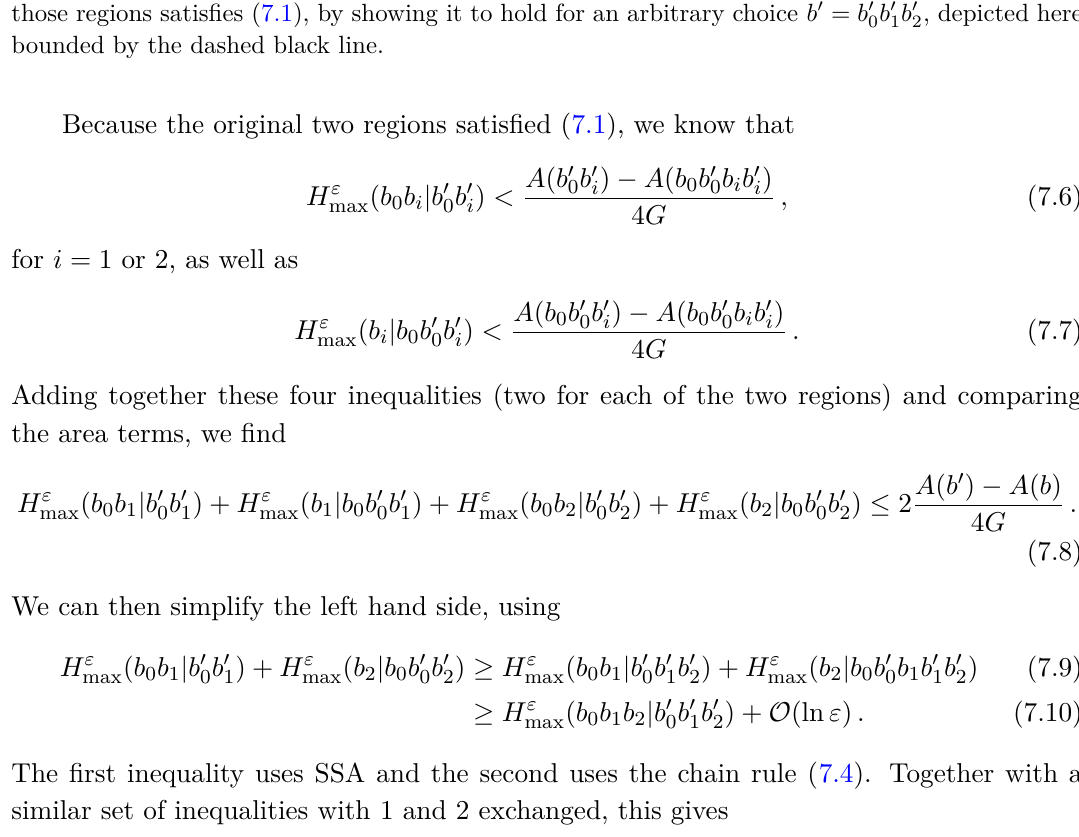
, depicted here b 0 b 0 0 1 2